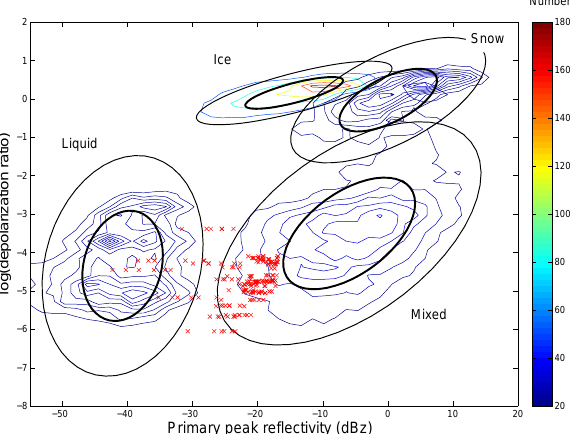
Figure 15. Contour lines show frequency of data points in training data set using color scale to the right. Ellipses indicate 1 and 2 sigma normal distributions for these two variables. Red x ’s correspond to values of drizzling conditions from the box in Fig.